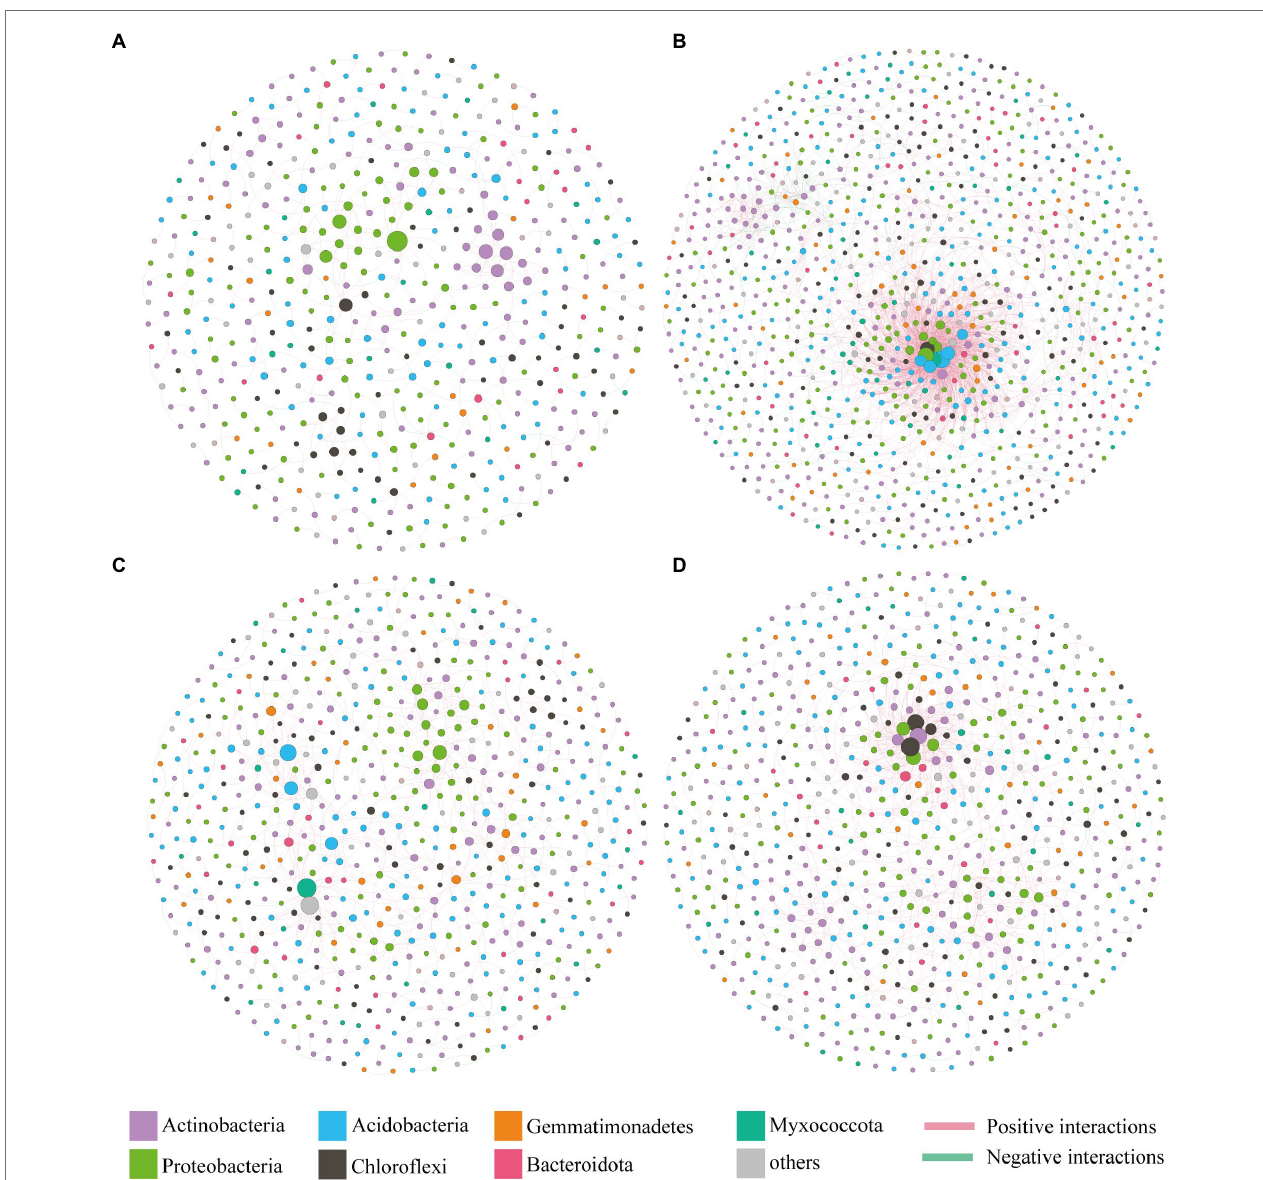
FIGURE 6 | Bacterial co-occurrence networks under different treatments. (A) Control; (B) Atr; (C) Bio; (D) Atr-Bio. Control: equivalent amount of methanol and ddH 2 O were added into native soil; Atr: native soil spiked with atrazine; Atr-Bio: atrazine-spiked soil with inoculation of strain AT-5; Bio: native soil with inoculation of strain